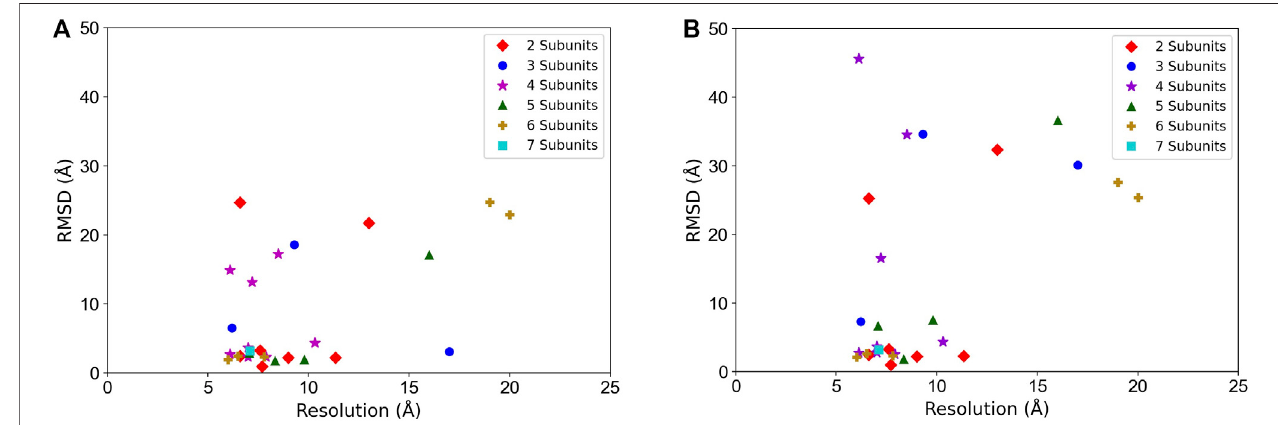
FIGURE5 | Structure fi ttingaccuracyrelativeto themap resolution. RMSD ofthe entire model structure ofcomplexesisplotted. (A) the best RMSD model among the top 10-scored models. (B) the top-scored models. Targets with different chain numbers are separately